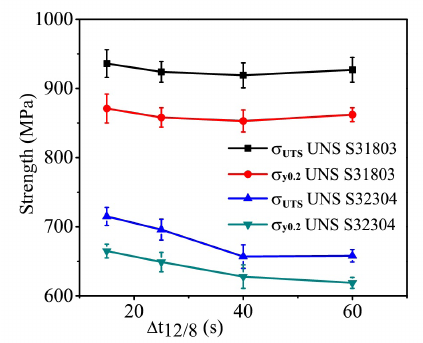
Figure 6. Normalized hardness of the HAZs at different cooling times for both DSSs (UNS S31803 and UNS S32304).